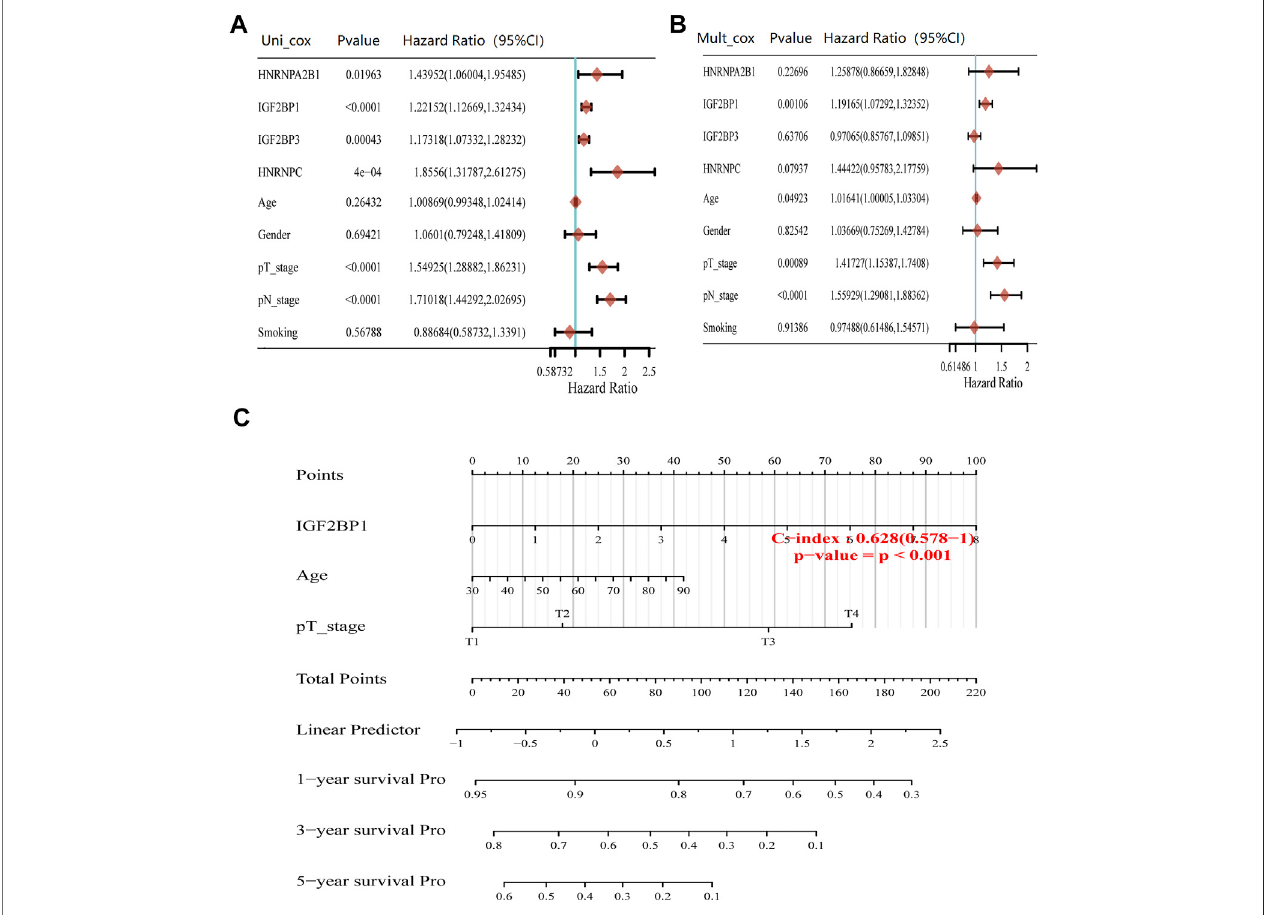
FIGURE 4 | Prognosis value of m 6 A modi fi cation regulators in LUAD. (A) Forest plots for hazard ratios of univariate Cox regression analysis of m 6 A modi fi cation regulatorsandclinicalrelative factorsinLUAD. (B) Forestplotsforhazardratiosofmultivariate Coxregressionanalysisofm 6 Amodi fi cationregulatorsandclinicalrelative factors in LUAD. (C) Nomogram to predict the overall survival at 1, 3, and 5 years of m 6 A modi fi cation regulators and clinical relative factors in